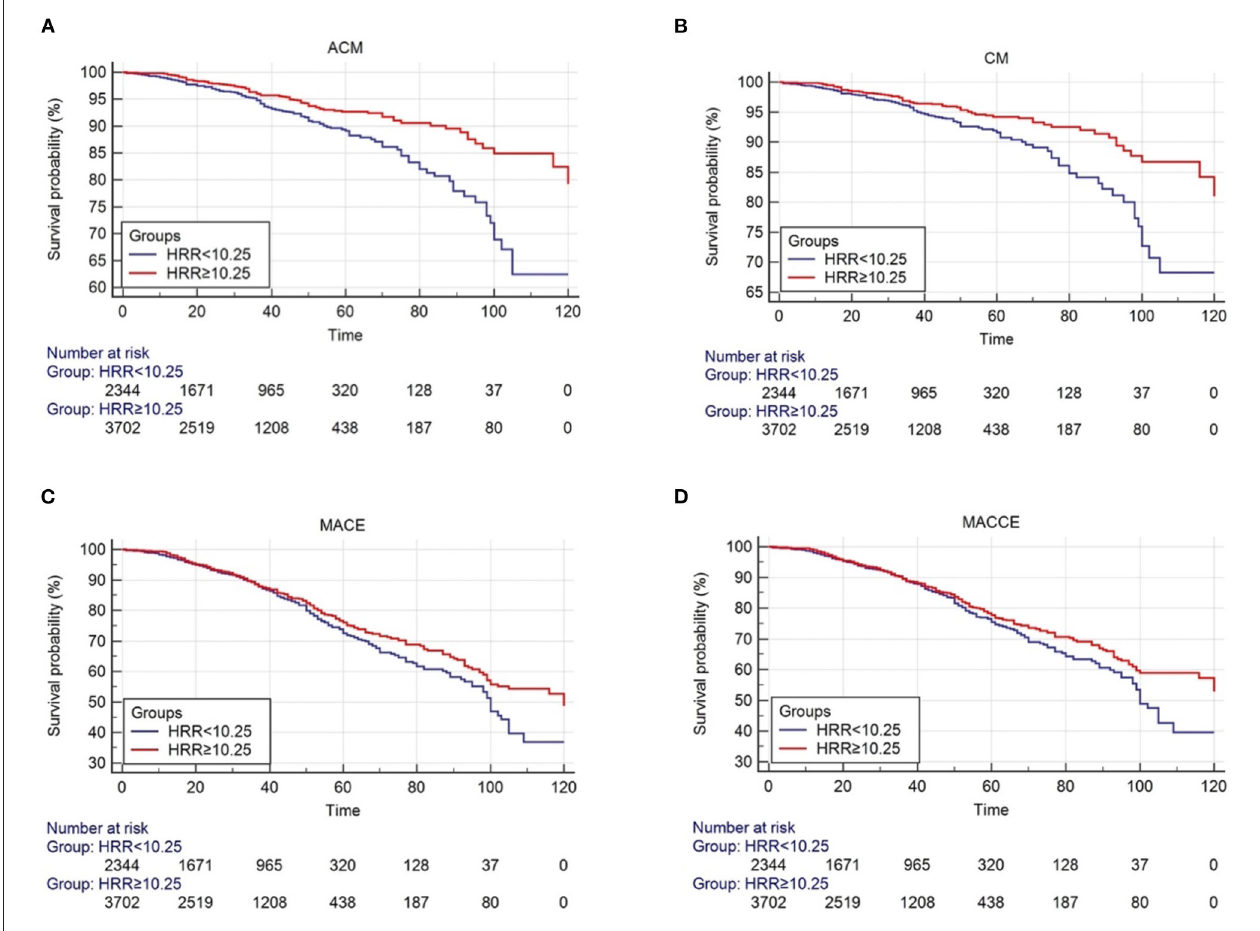
FIGURE 2 | Cumulative Kaplan-Meier estimates of the time to the first adjudicated occurrence of primary endpoint and secondary endpoints. (A) ACM; (B) CM; (C) MACE; (D) MACCE.